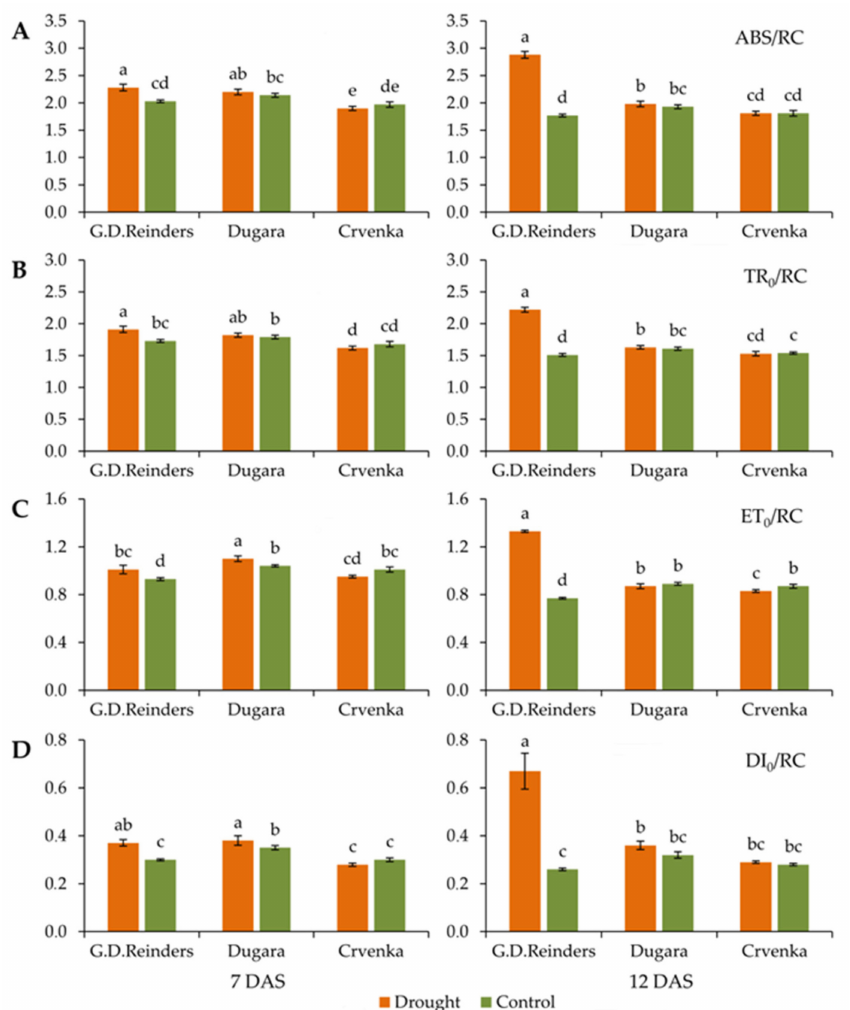
Figure 1. Absorption per active reaction center (ABS/RC) ( A ), trapped energy flux per active reaction center (TR 0 /RC) ( B ), electron transport flux per active reaction center (ET 0 /RC) ( C ), dissipation energy per active reaction center (DI 0 /RC) ( D ), measured in control and drought-stressed apple cultivars (“Golden Delicious Reinders”, “Crvenka” and “Dugara”) at 7 and 12 DAS (day after stress). Values are presented as relative units. Values are mean ± SE ( n = 15). Different letters indicate significant difference among treatments and cultivars at p < 0.05 according to the LSD